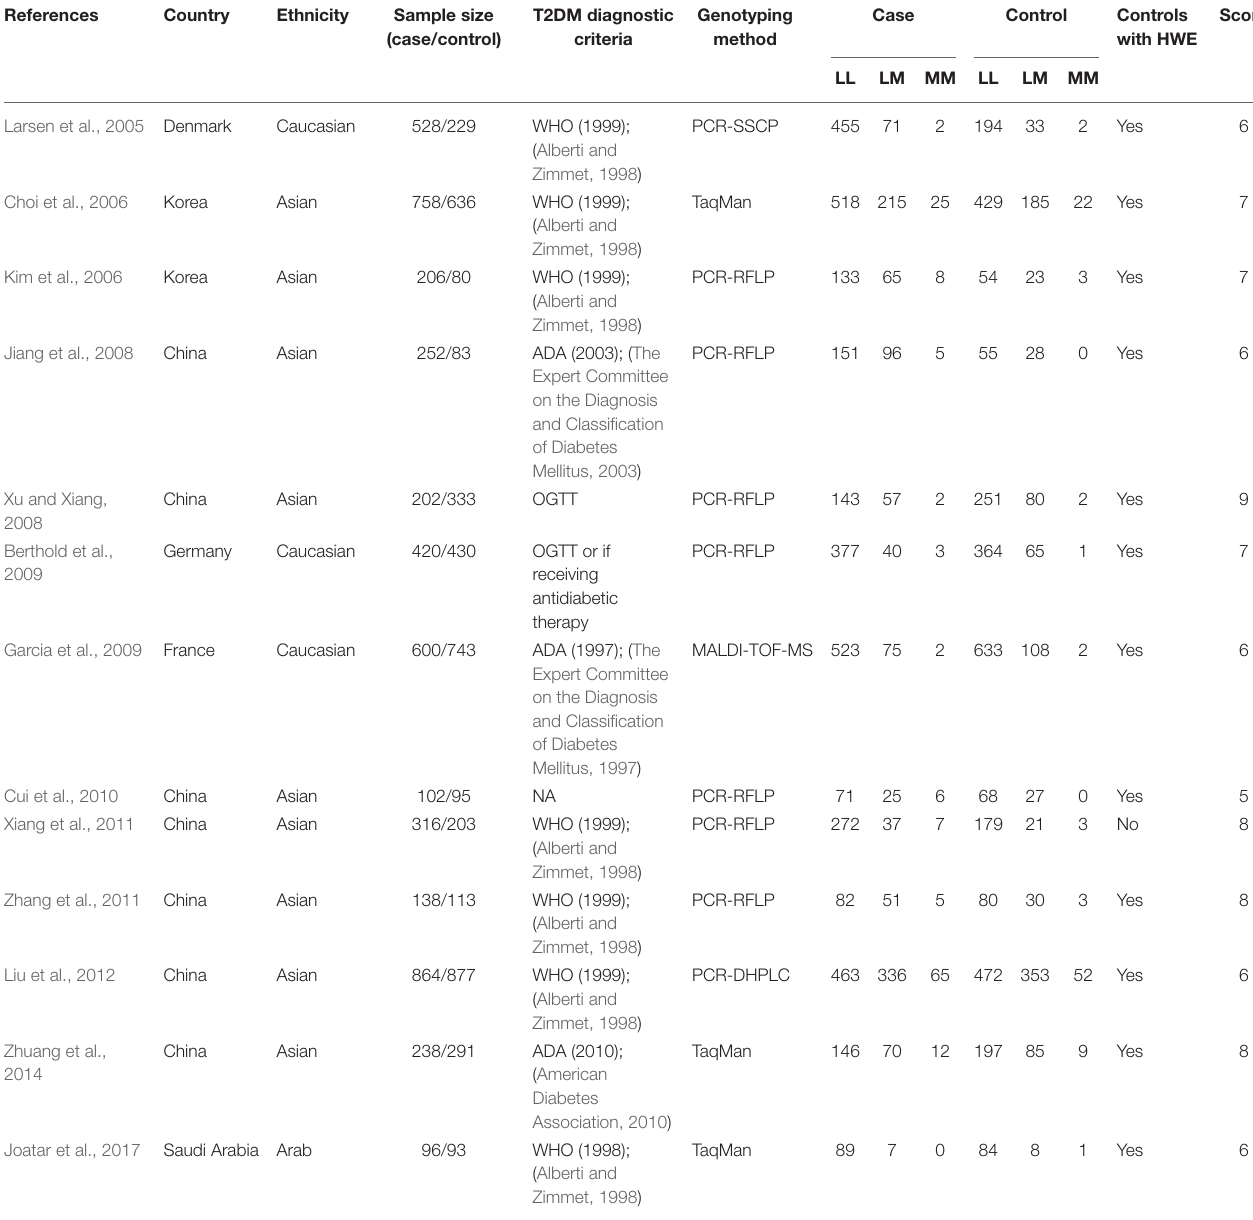
TABLE 1 | Study characteristics from included studies in the